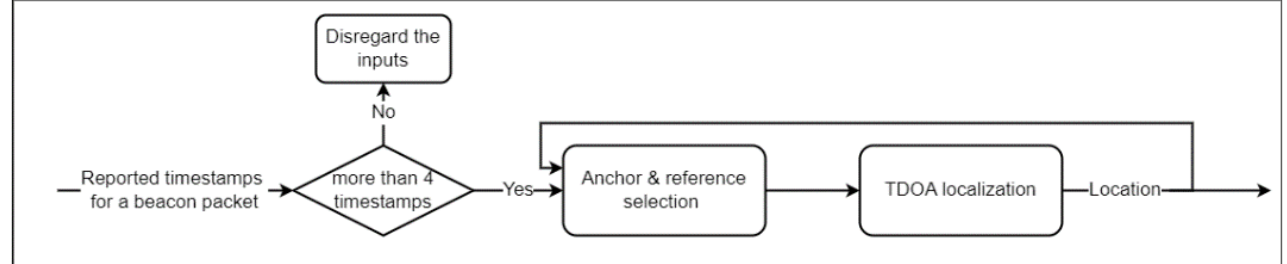
Figure 2. Overview of the TDOA input correction in ViPER+.